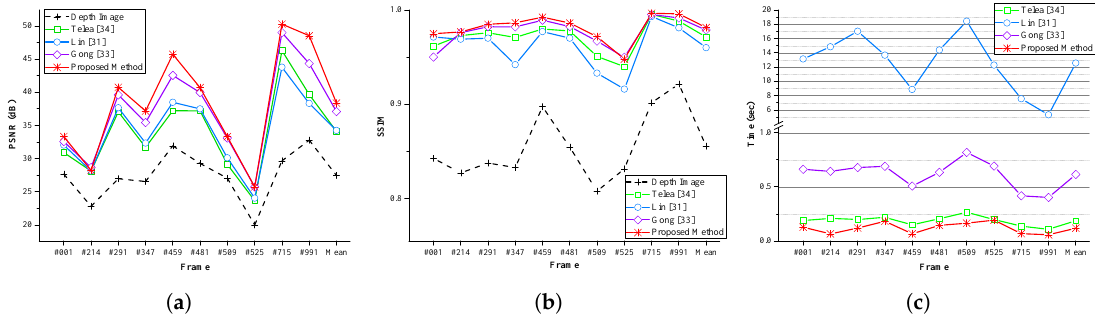
Figure 13. Comparison of ( a ) PSNR; ( b ) SSIM; and ( c ) running time on the selected Tsukuba Stereo Dataset.